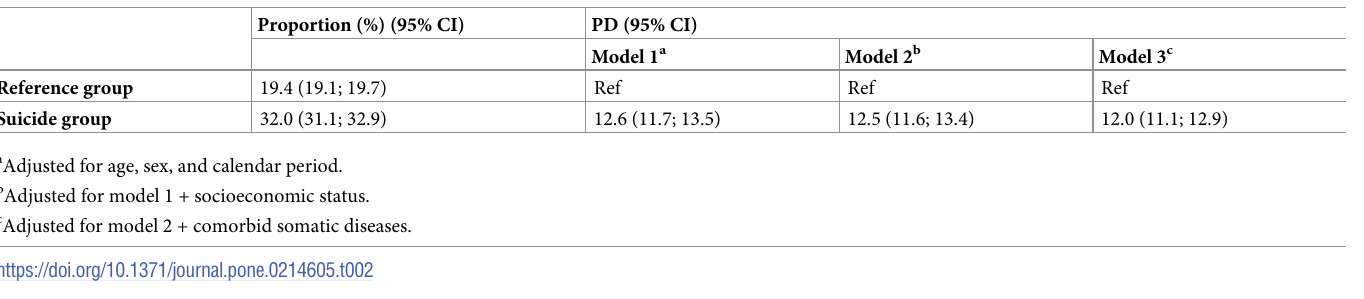
Table 2. Proportion and proportion difference (PD) for daytime face-to-face contacts in the month before index